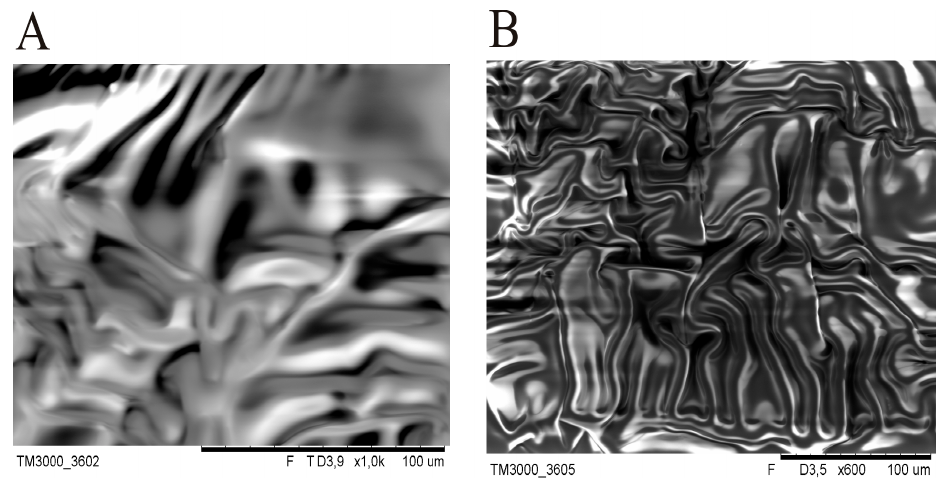
Figure 3. Deformation and flowing of the adhesive layer as a result of the electron bombardment in SEM: ( A ) 3.9 kV; ( B ) 3.5 kV.